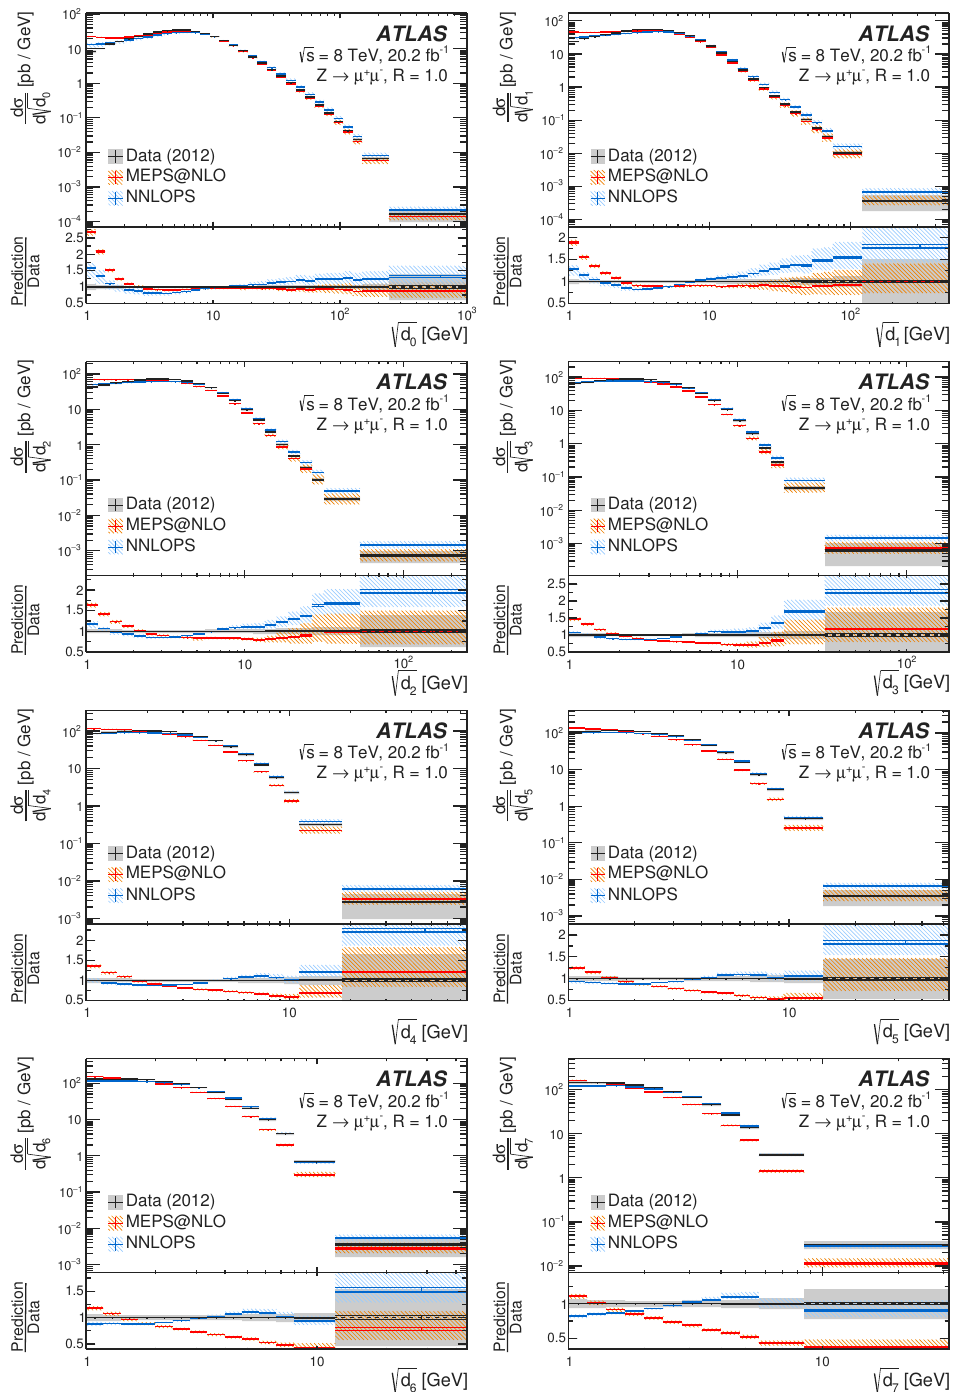
Figure 8. Charged-only distributions for the eight leading splitting scales in the muon chan- nel using the jet-radius parameter R = 1 : 0. The size of the error bars re(cid:13)ects the statistical uncertainty, while the combined statistical and systematic uncertainty is indicated by the grey band. Theoretical predictions from Sherpa with NLO multijet merging (\MEPS@NLO") and from Powheg + Pythia 8 with NNLO matching (\NNLOPS") are displayed.